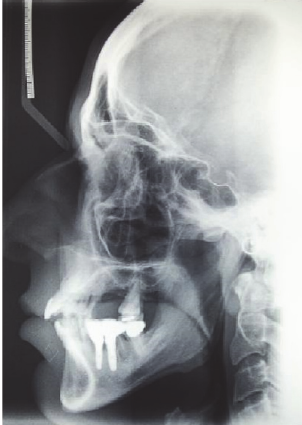
Figure 3: Starting case, teleradiographic exam.